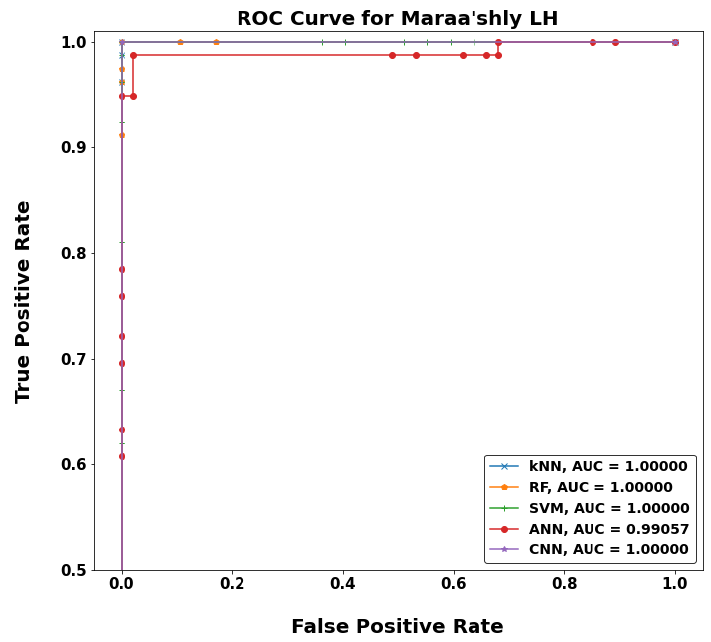
Figure 21. ROC curves for WF- ML models in Maraa’shly LH.